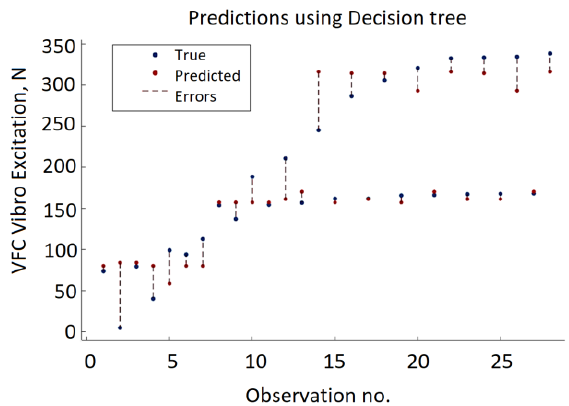
Figure 15. Minimum MSE during DT hypermeters’ optimization process.